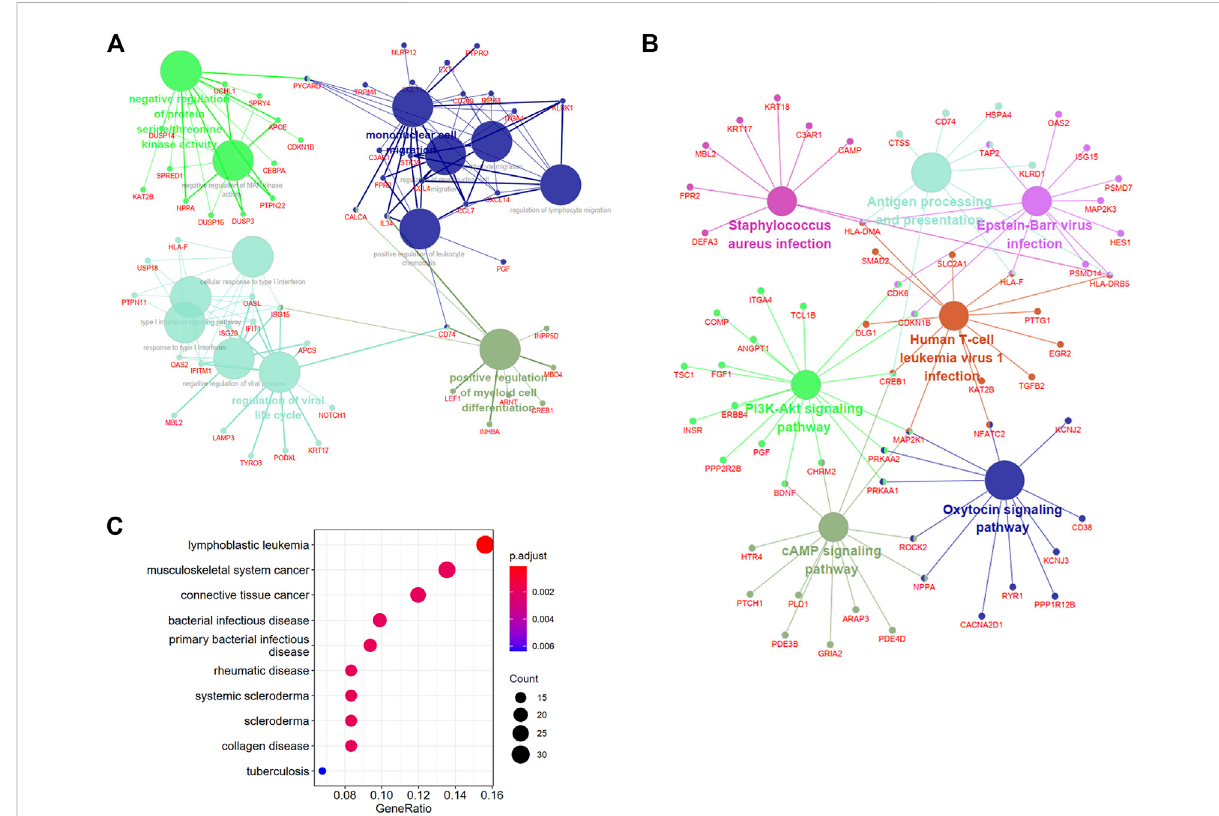
FIGURE 5 Biological annotations and DO analysis of DEARGs. (A) and (B) The enrichment network of biological processes and KEGG pathways with the participated genes in Cluego software. (C) The diseases of DEARGs involved through Disease Ontology analysis. DEARGs, differentially expressed autoimmune-related genes; DO, Disease